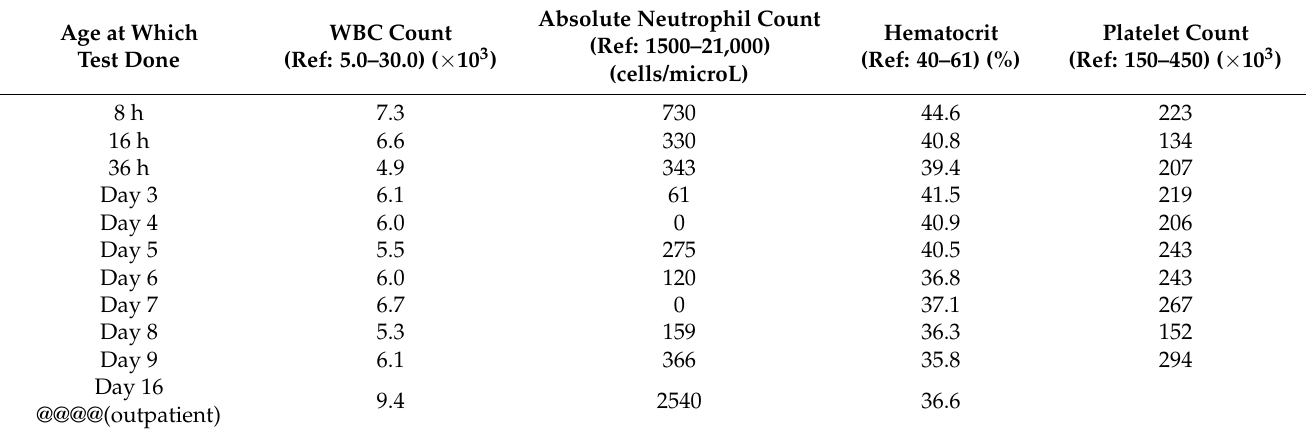
Table 1. Serial blood counts in infant during the hospital stay, showing a nadir between days 4–7, followed by